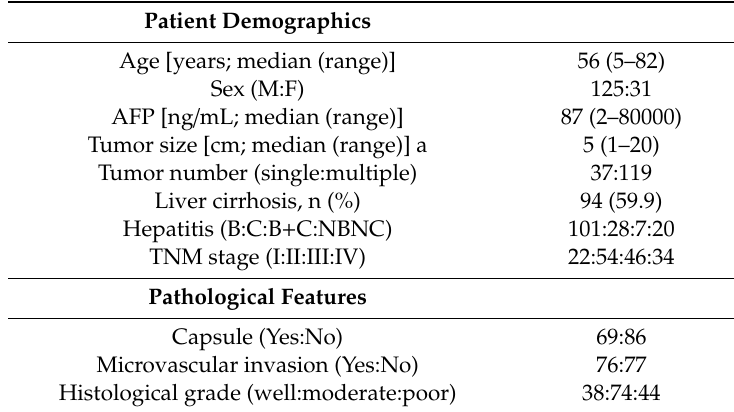
Table 4. Clinicopathological features of 156 patients with HCC undergoing